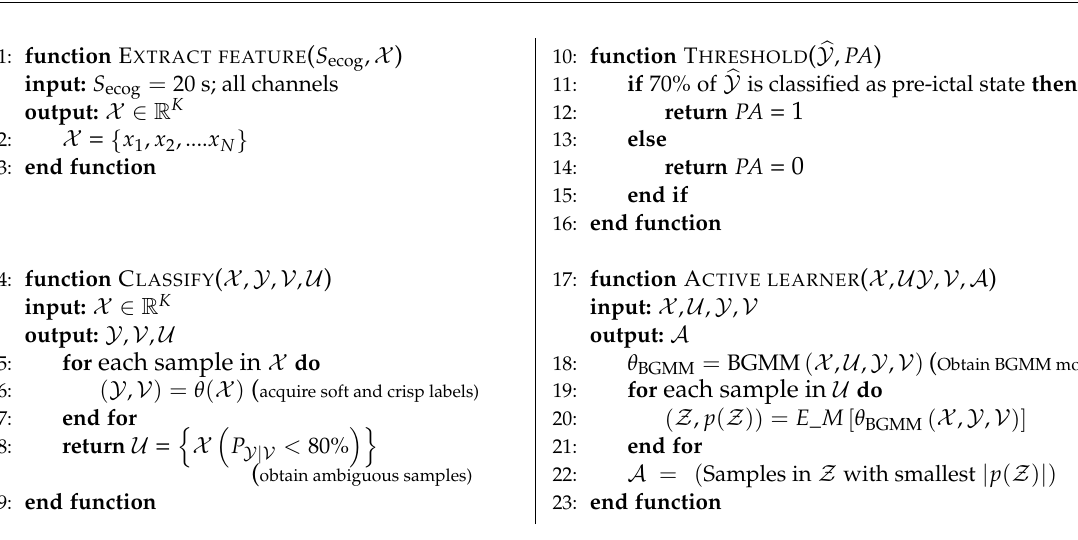
Algorithm 1 Pseudo-code of individual